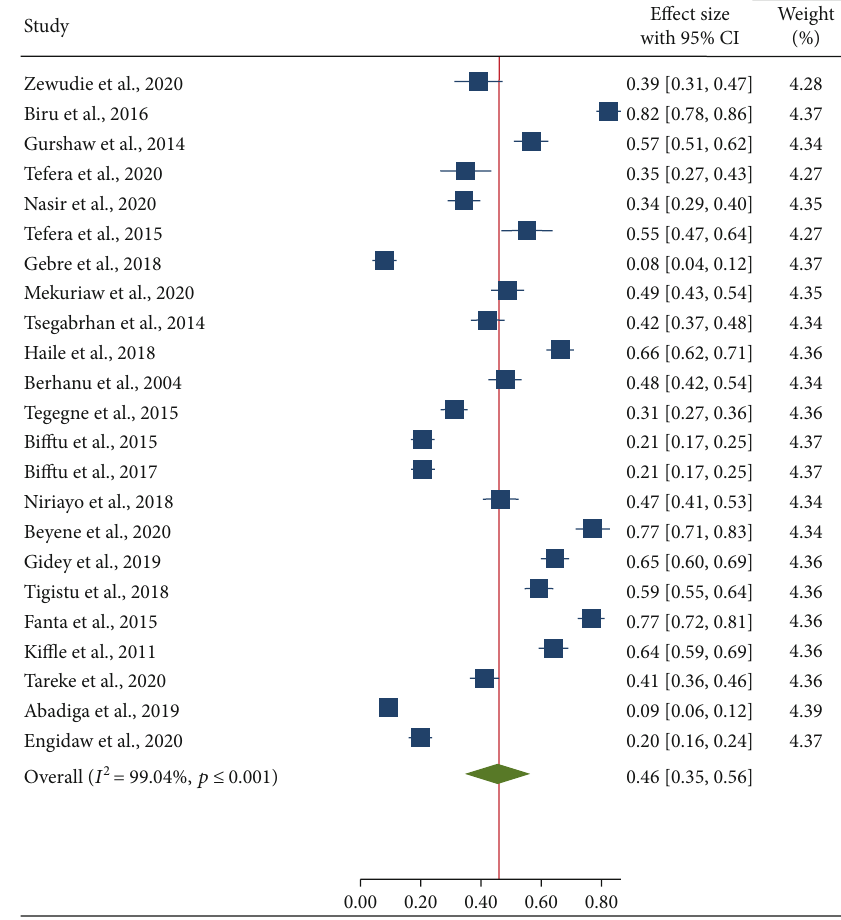
Figure 2: Forest plot illustrating the pooled prevalence of seizure freedom of 23